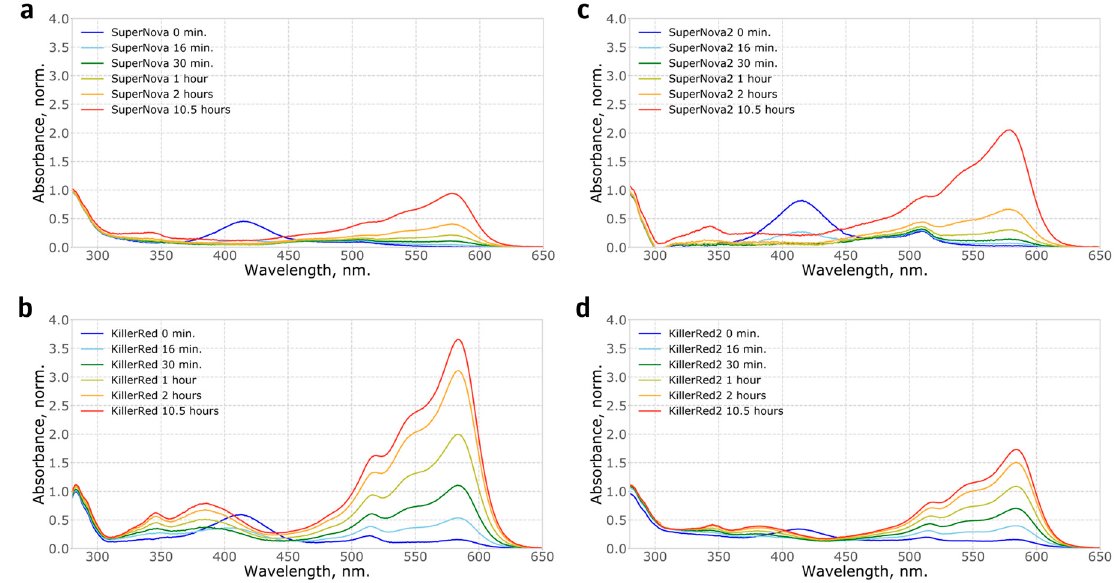
Figure 2. Kinetics of the absorption spectra showing chromophore maturation in vitro for recombinant: ( a ) SuperNova; ( b ) KillerRed; ( c ) SuperNova2; ( d ) KillerRed2 proteins. Spectra are normalised to the absorption at 280 nm. Notably, the completeness of chromophore maturation in these experiments was different from protein samples purified from bacterial culture likely reflecting the difference in maturation conditions of the proteins, such as temperature, pH and oxygen availability.